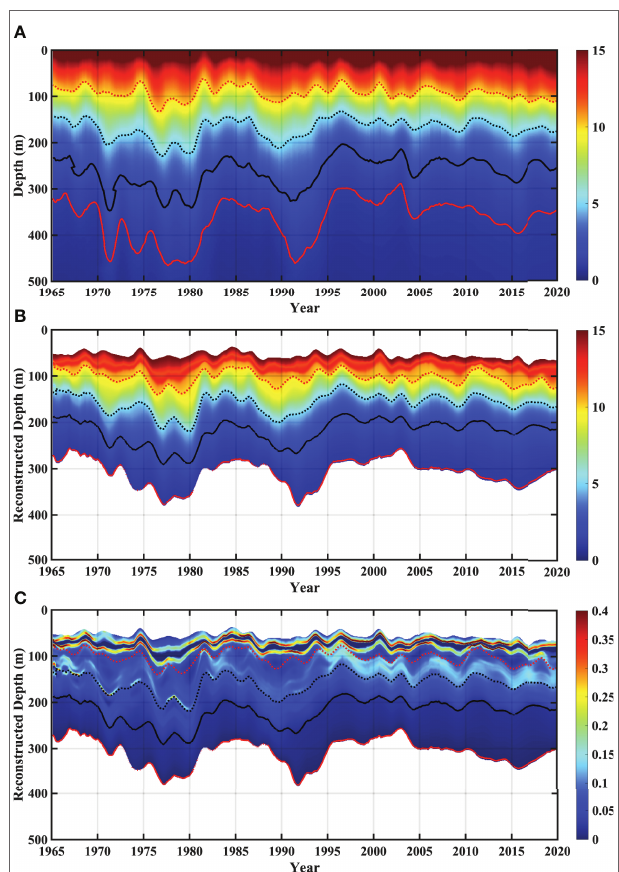
FIGURE 9 | (A) Temporal variability of mean temperature profile averaged over the NIFS observation domain on the depth (z) surfaces. (B) Same as panel (A) , but on the isothermal surfaces. (C) Vertical temperature gradient of mean temperature profiles shown in panel (B) Unit of panel (C) is °C/m. Red lines, black lines, black dotted lines, and red dotted lines denote 1°C, 2°C, 5°C, and 10°C isotherms,